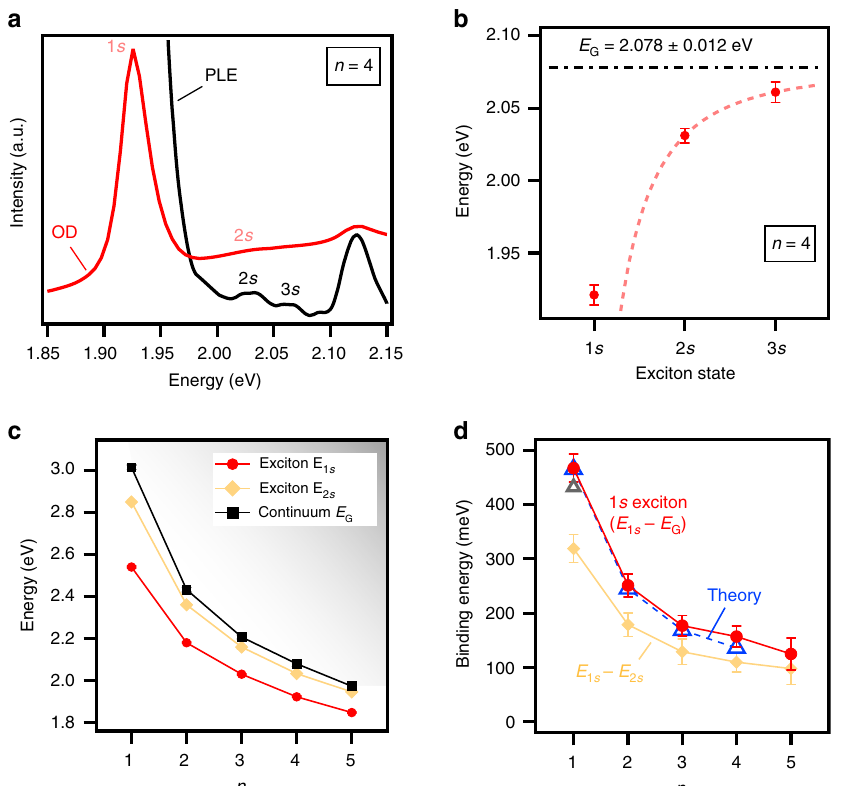
Fig. 4 Direct measurement of the exciton binding energy and Rydberg states in RPPs with n equals 1 to 5. a Optical density OD and photoluminescence excitation PLE spectra of the RPP with n equals to 4 (see the others in Supplementary Fig. 9) clearly showing the exciton ground state 1 s and the excited exciton states 2 s and 3 s . b Corresponding energy of the exciton Rydberg states. Dashed line is a fi t to the 2 s and 3 s states with the 2D hydrogen model 26 of exciton Rydberg series using R y = 0.11 ± 0.04 eV and E G = 2.078 ± 0.012eV in the formula E Ns = E G − R y /( N − 1/2) 2 , with Ns equals to 1 s , 2 s , 3 s . c Evolution of the exciton ground state, fi rst excited state 2 s , and continuum energies with the 2D perovskite layer thickness (or n ). d Corresponding experimental binding energy of the exciton ground state (1 s ) and the excited exciton states (2 s , 3 s , 4 s ), and comparison to theoretical results for the exciton ground state. The gray open triangle corresponds to the 1 s exciton binding energy calculated for the diamagnetic shift obtained by Tanaka et al. 15 in a RPP with n equals to 1 with larger organic spacers (see Fig. 1d, e). The values E 1 s − E 2 s provide a lower limit for the exciton binding energy. Error bars correspond to s.d. from the determination of the energy of the exciton